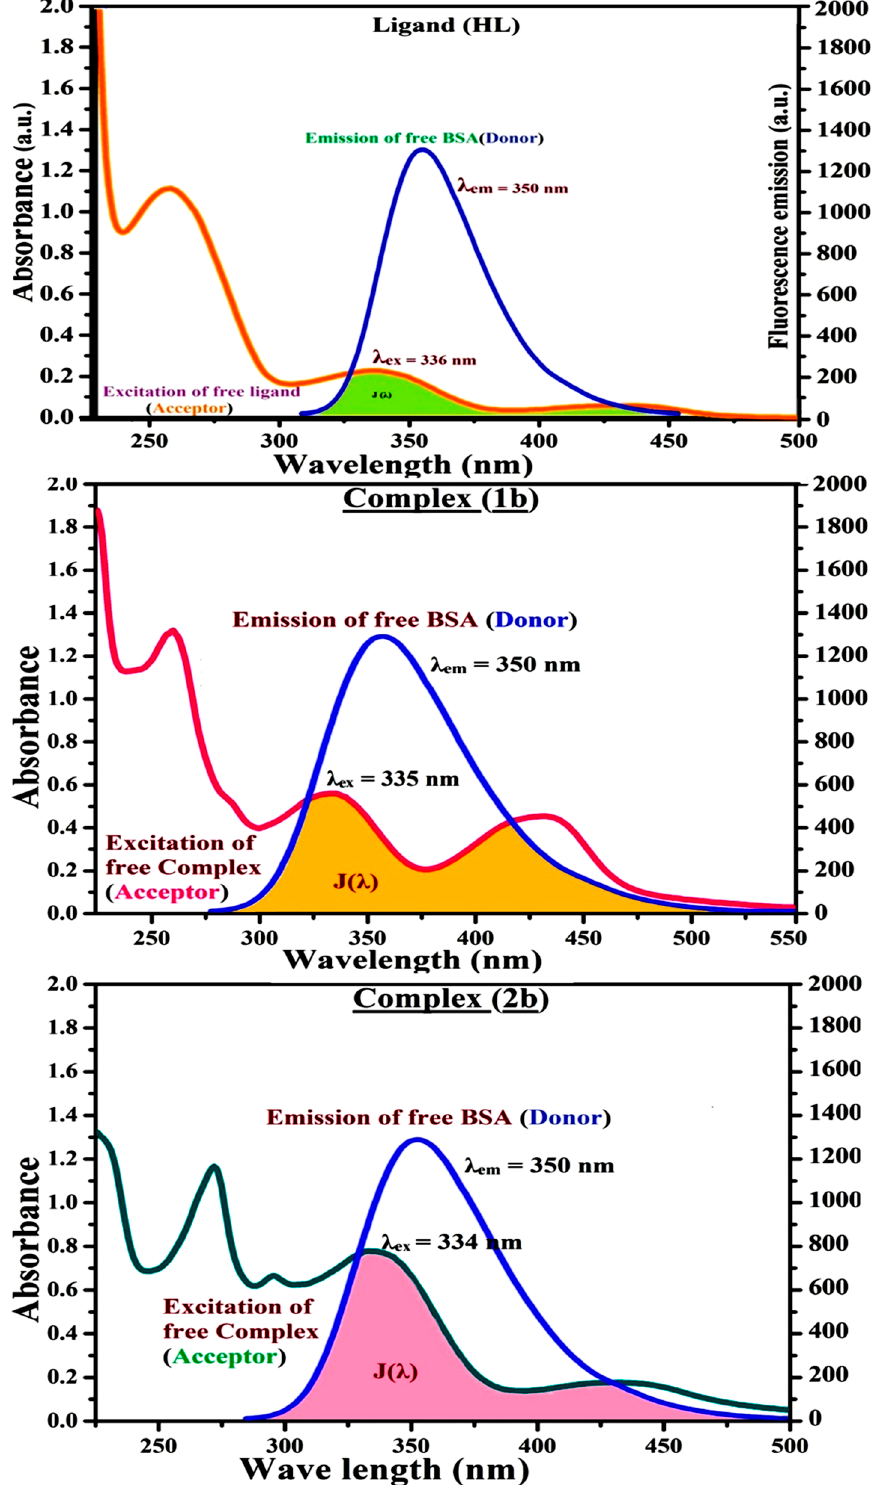
Figure 6. The overlap of UV–Vis spectra of ligand ( HL ) and its complexes ( 1b – 2b ) ( Acceptor ) at 334– 336 nm with fluorescence emission spectrum of BSA ( Donor ) at 350 nm. 334–336 nm with fluorescence emission spectrum of BSA ( Donor ) at 350